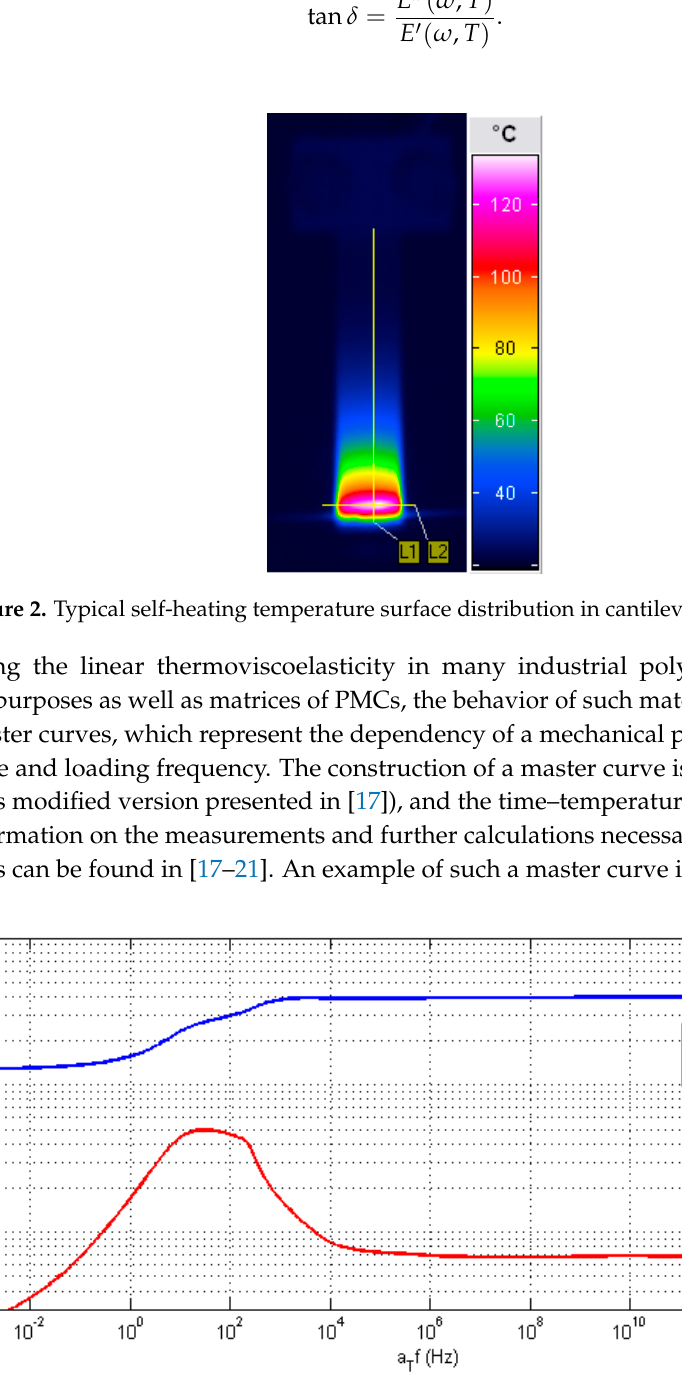
Figure 3. Exemplary master curves for the dynamic moduli for a glass fabric-reinforced PMC.